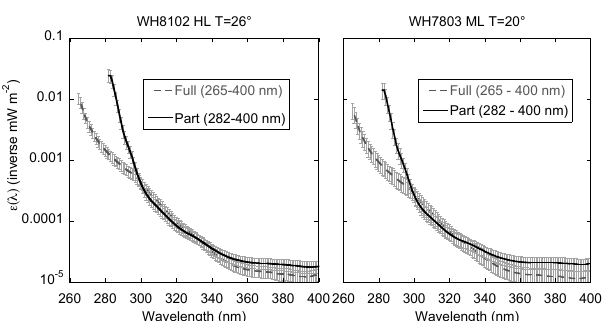
Figure 4. Fitted biological weighting functions ( ± standard error) for UV inhibition of photosynthesis in Synechococcus WH8102 (HL 26 ◦ C) and 7803 (ML 20 ◦ C) comparing results obtained using all the data from each experiment (“full”, n =120, shortest treatment wavelength 265nm) and a reduced data set, omitting the two treat- ments with spectral irradiance shorter than 282 nm (“part”, n